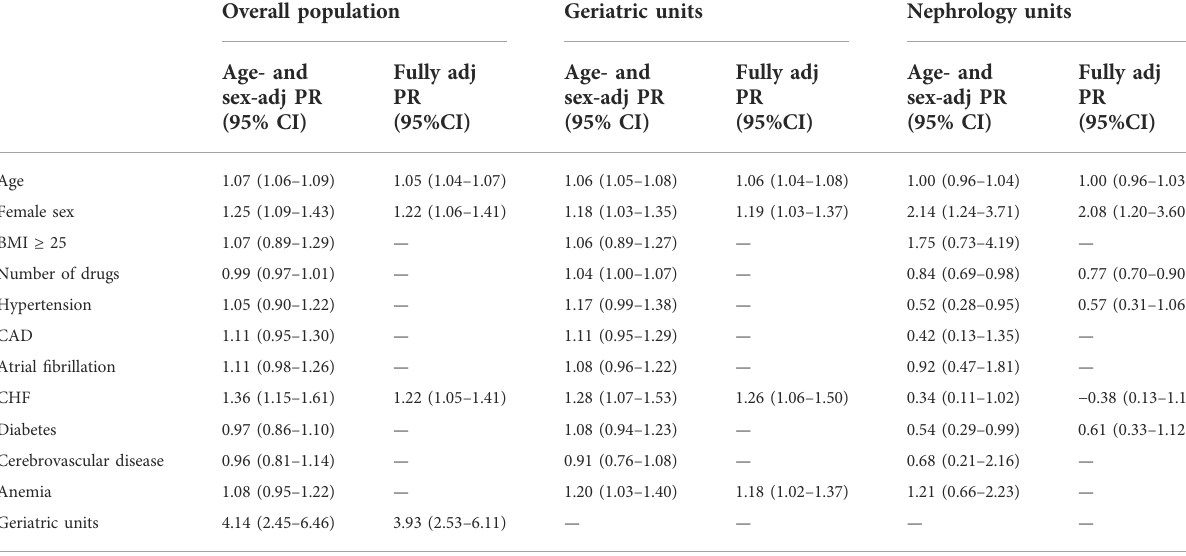
TABLE 2 Factors associated with CKD under-reporting in the study population and single